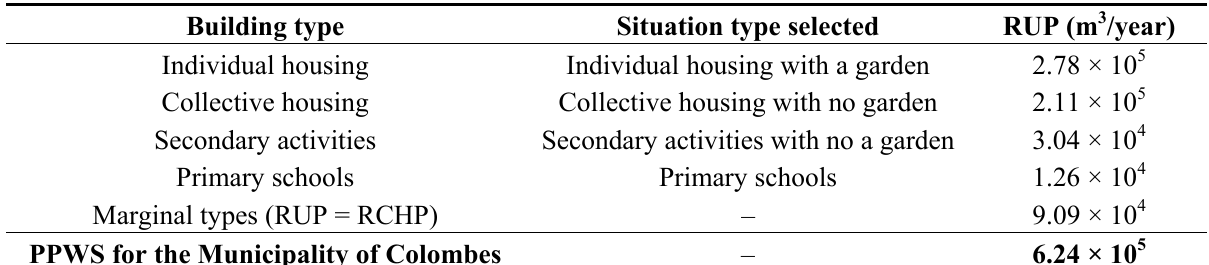
Table 8. RUP of the municipality of